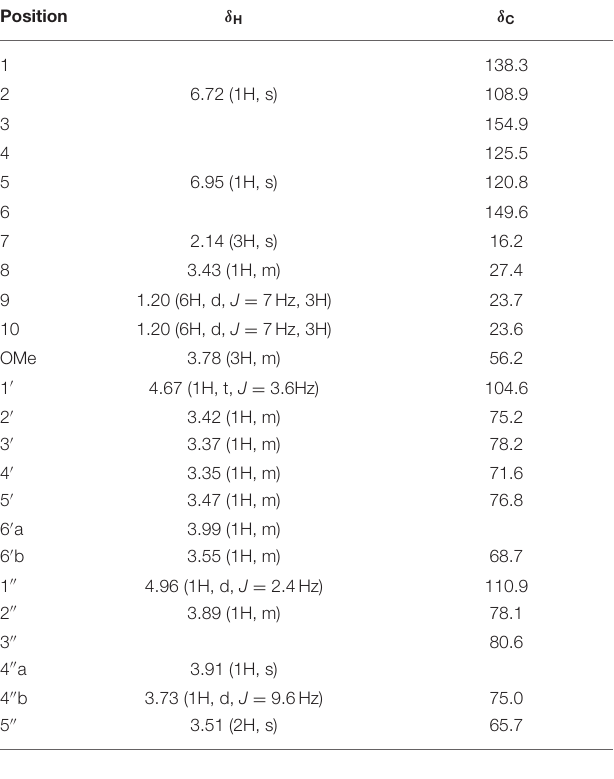
TABLE 2 | The 1 H and 13 C NMR data of 1 (CD 3 OD, δ in ppm, J in Hz). Position